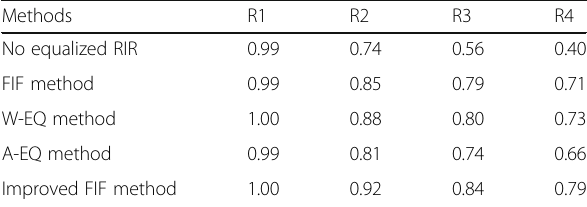
Table 3 Comparison of STI values of different methods